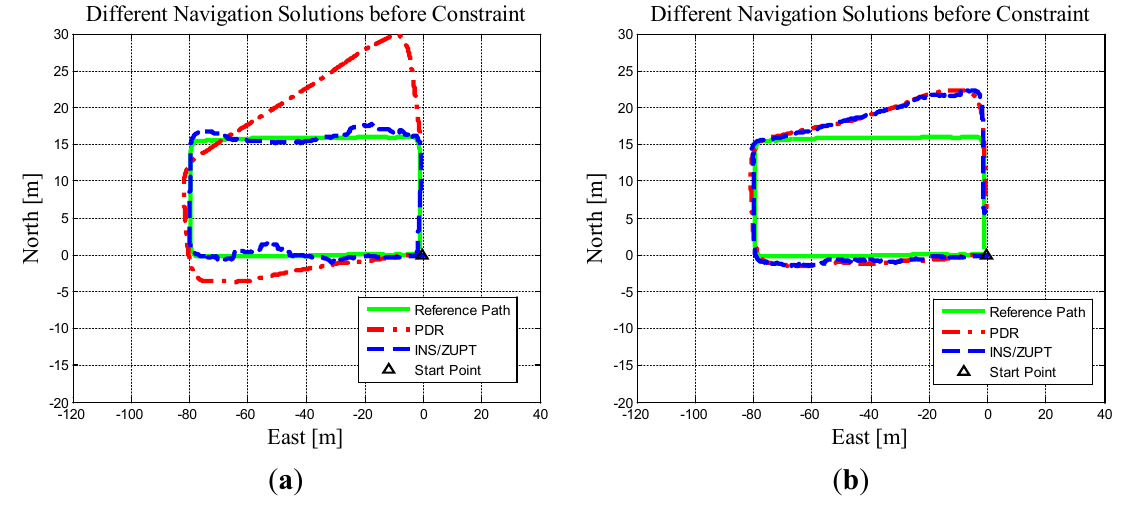
Figure 12. Trajectory V: Two systems’ navigation solutions. ( a ) Before constraint; ( b ) After constraint.